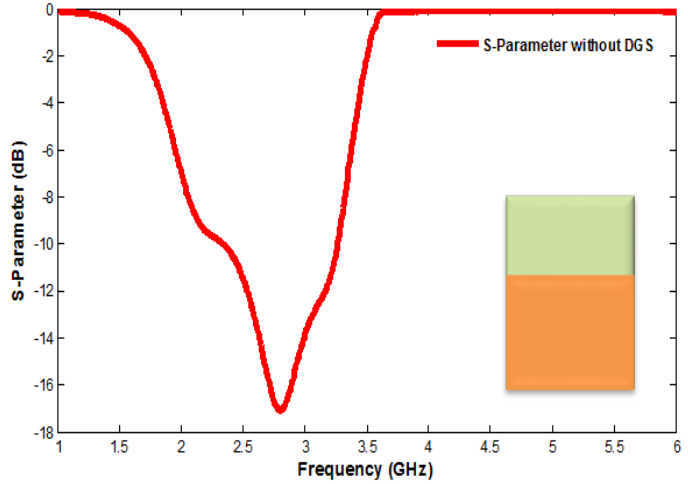
Figure 6. S 11 of the proposed filter-antenna without defected ground structure (DGS).